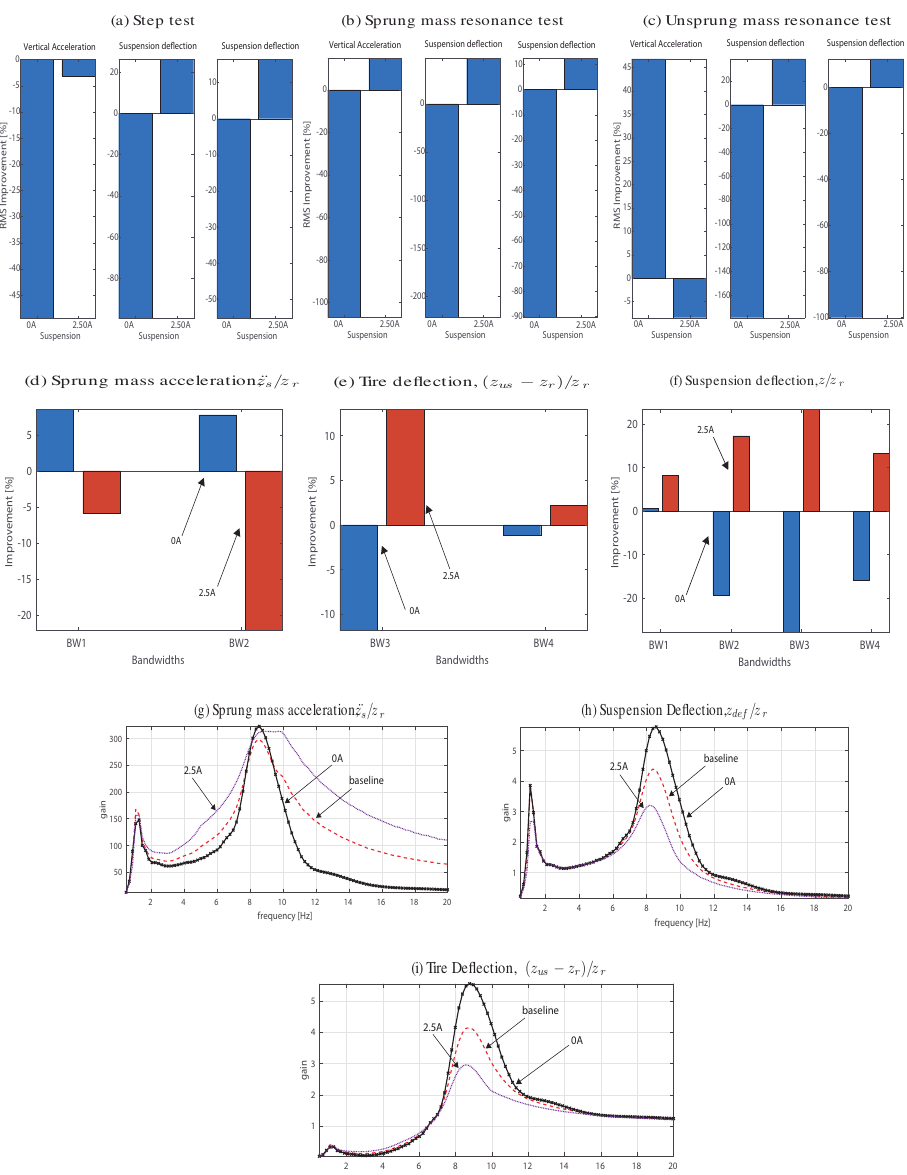
Figure 14. Results from open loop simulations for the comparison in a nonlinear modified QoV model considering a 1.25 A baseline